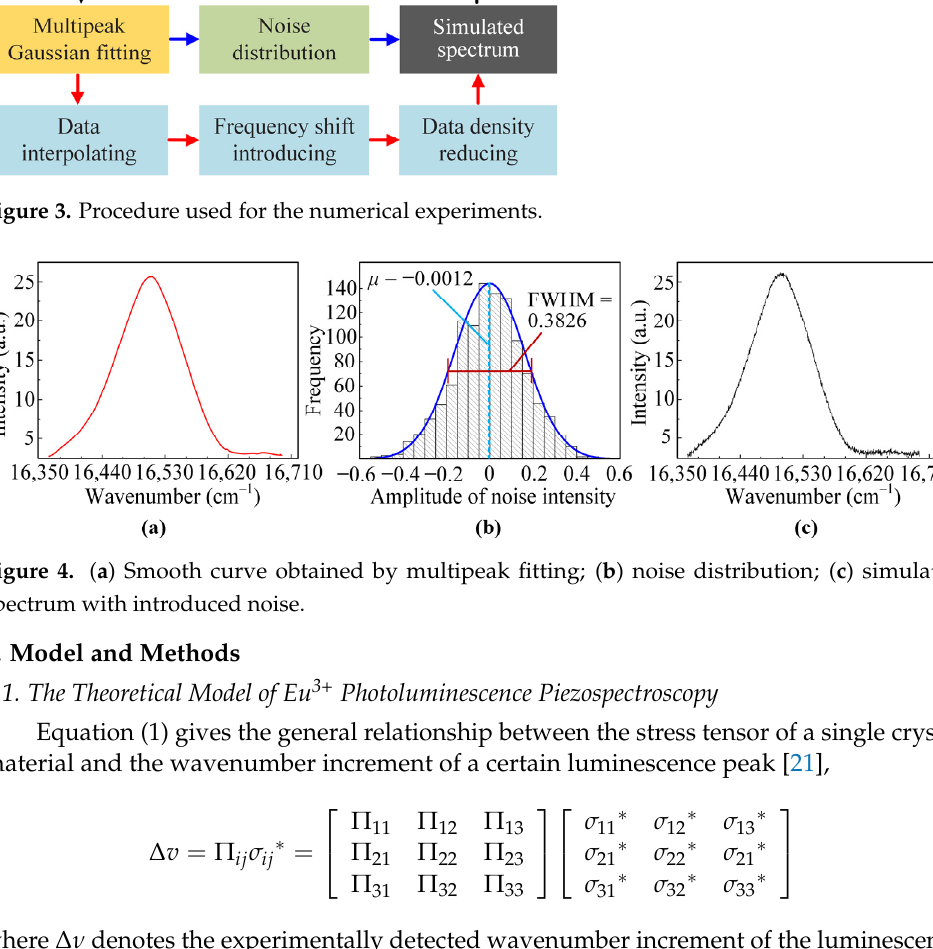
Figure 3. Procedure used for the numerical experiments.